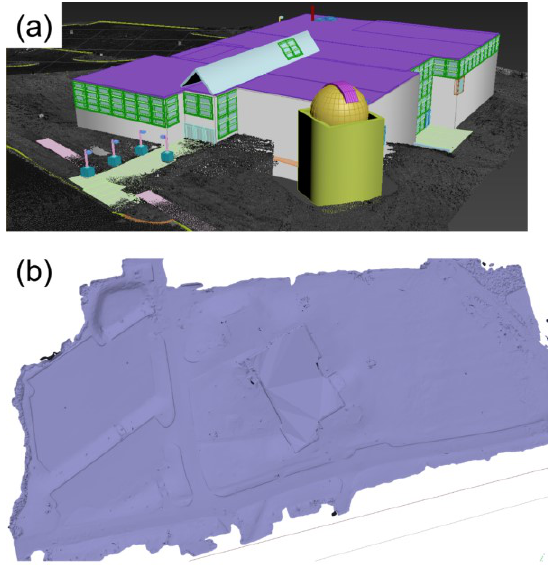
Figure 2. Terrain and 3D modeling; (a) Example of 3D modeling of man-made structures and buildings in Autodesk 3DS Max; (b) Terrain mesh in Agisoft Metashape from combined sUAS and TLS point clouds.